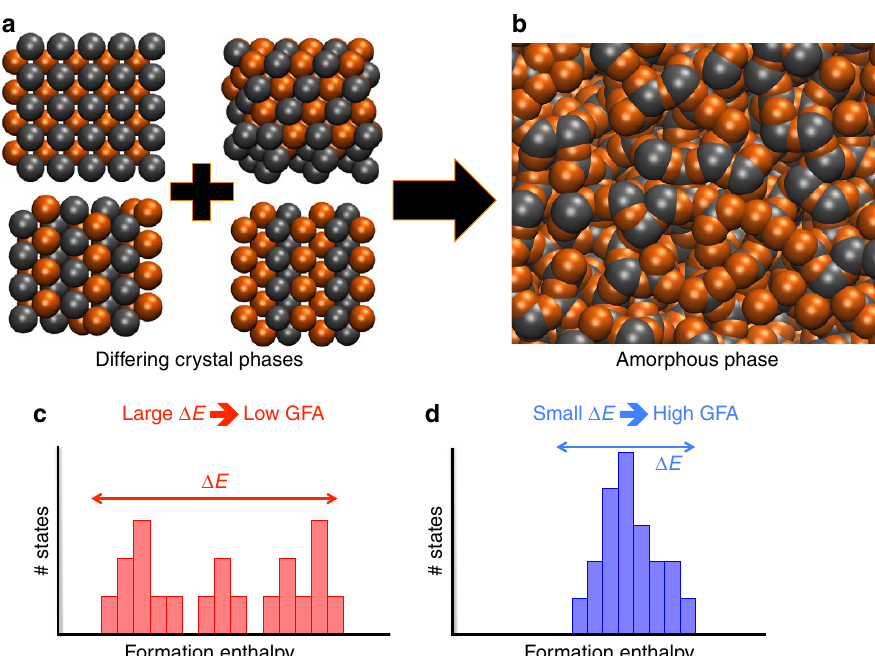
Figure 1 | Descriptor for confusion. If a particular alloy composition exhibits many structurally different stable and metastable crystal phases, which have similar energies, these phases will compete against each other during solidification, disrupting and frustrating the nucleation and crystallization processes, ultimately leading to an amorphous structure. ( a ) Distinct crystalline competing phases, which may compete and lead to ( b ) an amorphous structure. GFA should be ( c ) absent or ( d ) present, when the thermodynamic density of states is low or high, respectively.